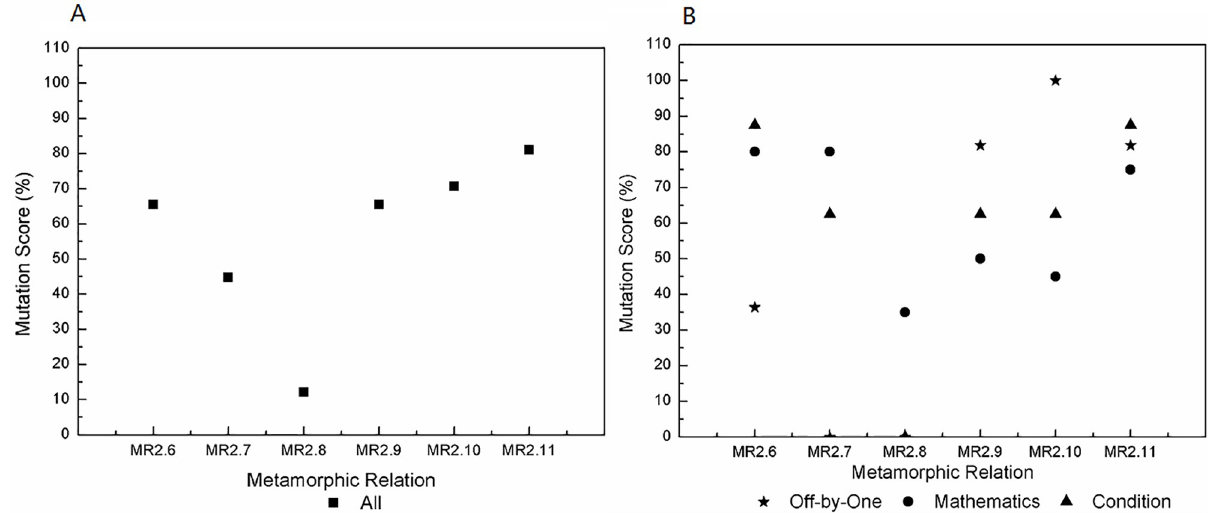
Fig 11. Mutation scores of the MRs based on the same source event sequence h counter deposit,counter deposit i . A: Those for all mutants. B: Those for different types of mutants.